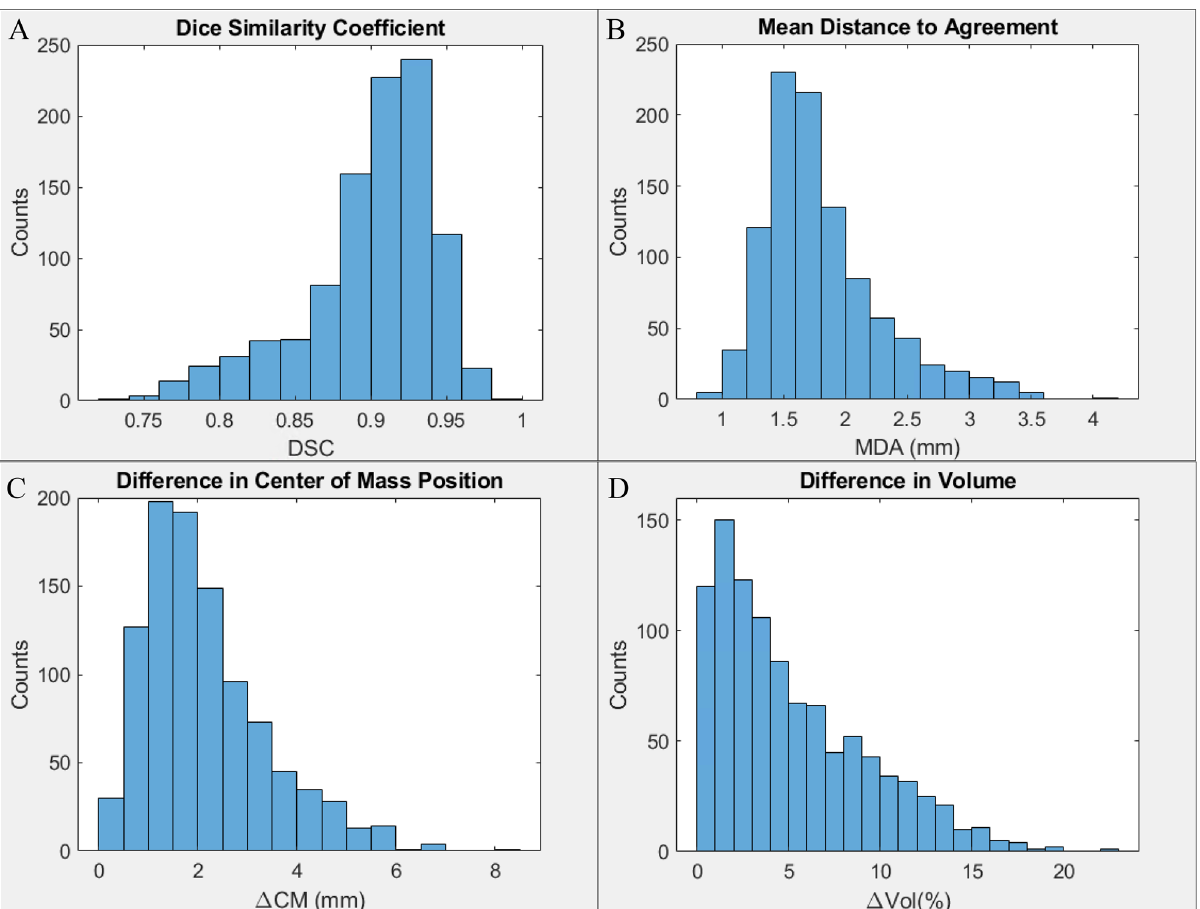
Figure 2. Histograms of ( A ) DSC, ( B ) MDA, ( C ) ΔCM and ( D ) %Δ volume between the auto and manual contours for all 1010 fractions are shown in ( A )–( D )